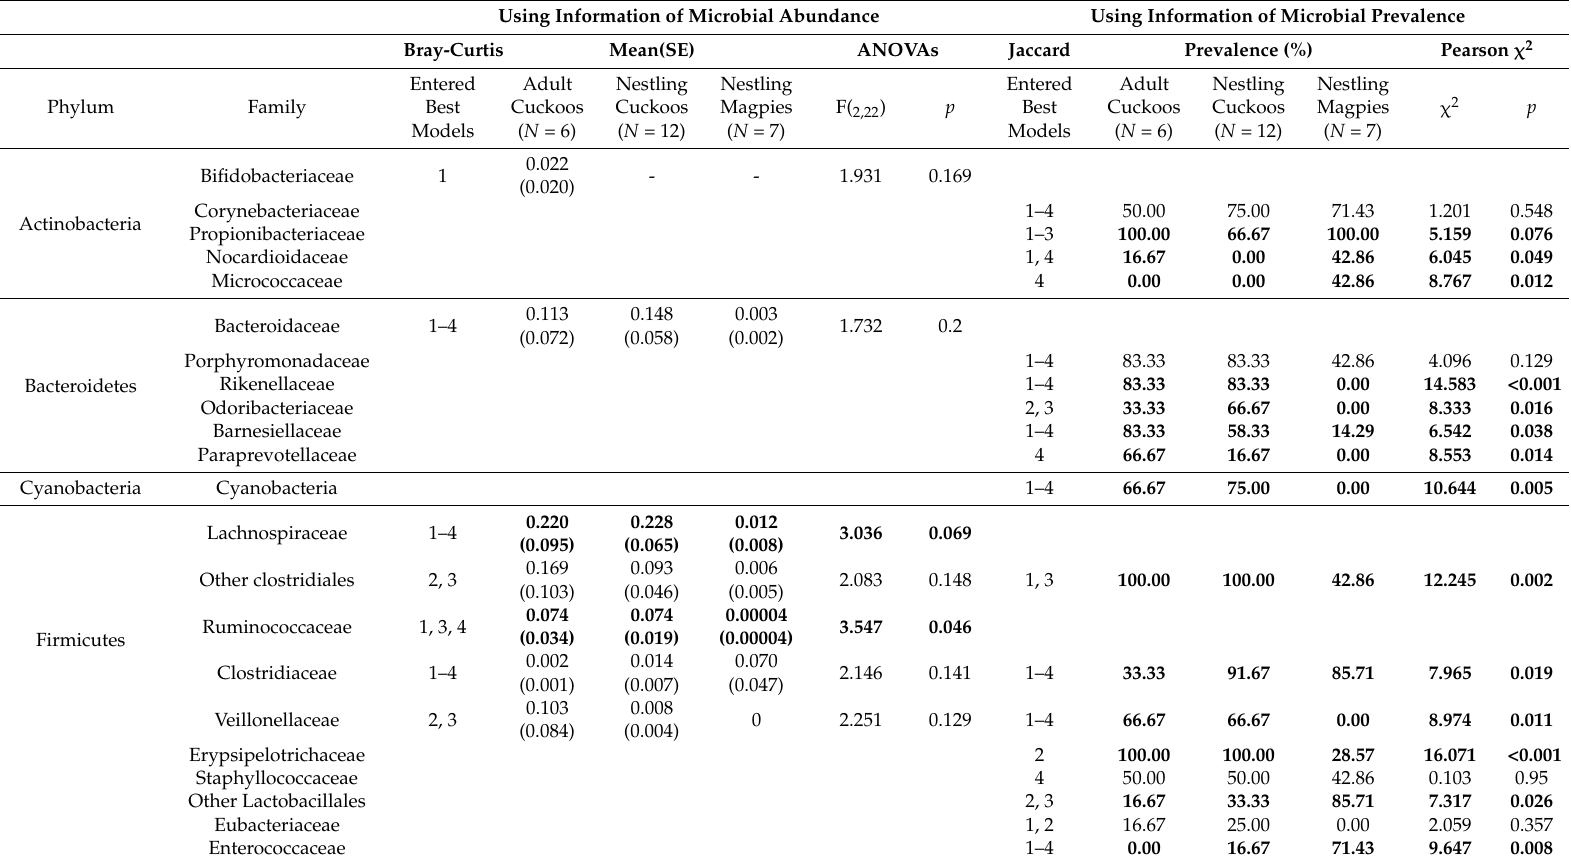
Table 2. Bacterial families that entered in the four Bray-Curtis best models (Model 1: r = 0.954, Model 2: r = 0.959, Model 3: r = 0.959, Model 4: r = 0.955) or in the four Jaccard best subject models (Model 1: r = 0.955, Model 2: r = 0.952, Model 3: r = 0.952, Model 4: r = 0.952). Mean values of abundance ± standard error (SE) of families that entered in Bray-Curtis best subset models of samples from adult cuckoos and from cuckoo and magpie nestlings are provided, as well as the results from comparisons (ANOVAs) between the three types of samples. Similarly, prevalence (%) of families that entered in the Jaccard best subset models are shown for samples from adult cuckoos and from cuckoo and magpie nestlings, as well as the results from comparisons (Pearson χ 2 ) between the three types of